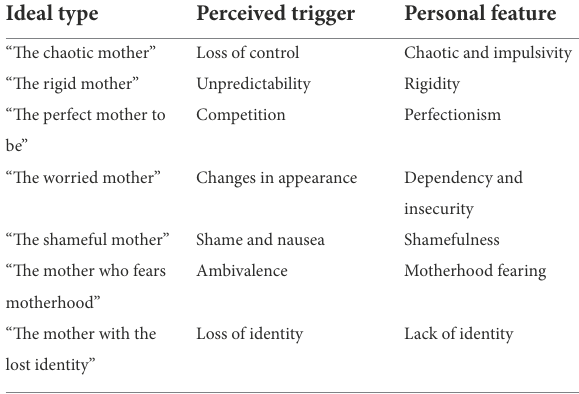
TABLE 2 Ideal types, perceived triggers and personal